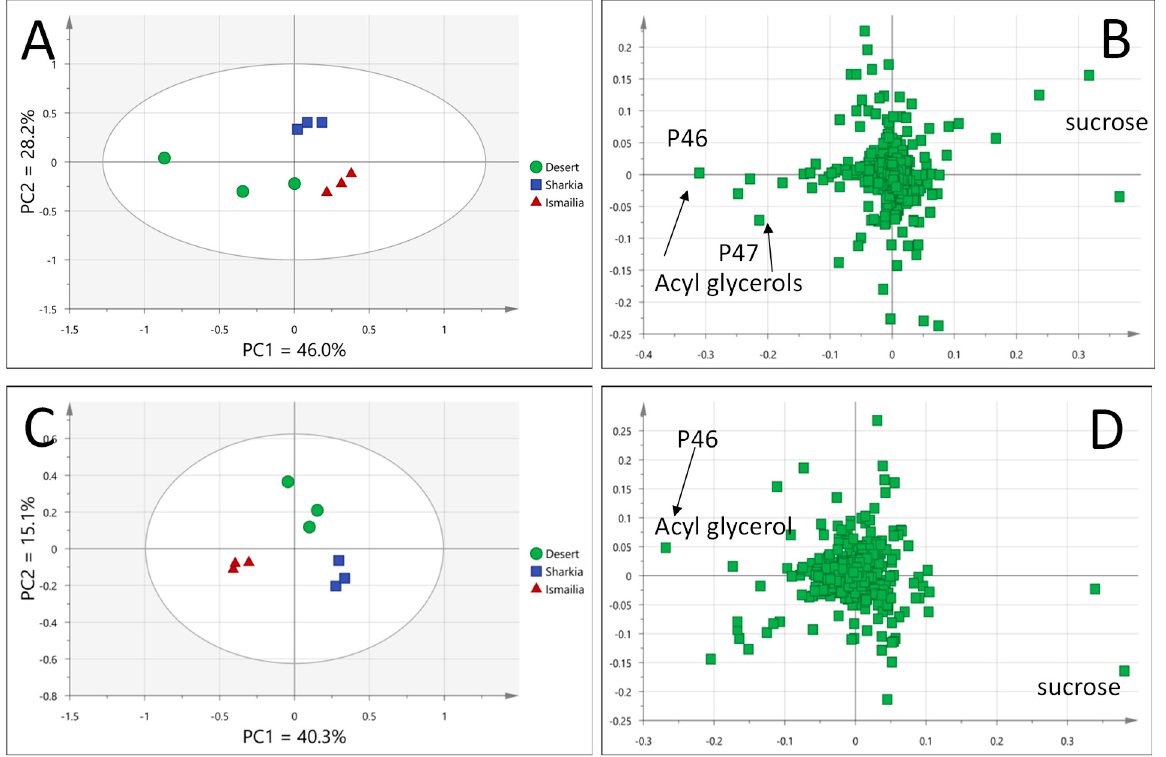
Figure 5. UPLC/MS PCA score plot of Awees cv. collected from different geographical origins ( A ), PCA loading plot of Awees cv. model ( B ), PCA score plot of Zibdea cv. collected from different geographical origins ( C ), PCA loading plot of Zibdea cv. model ( D ).